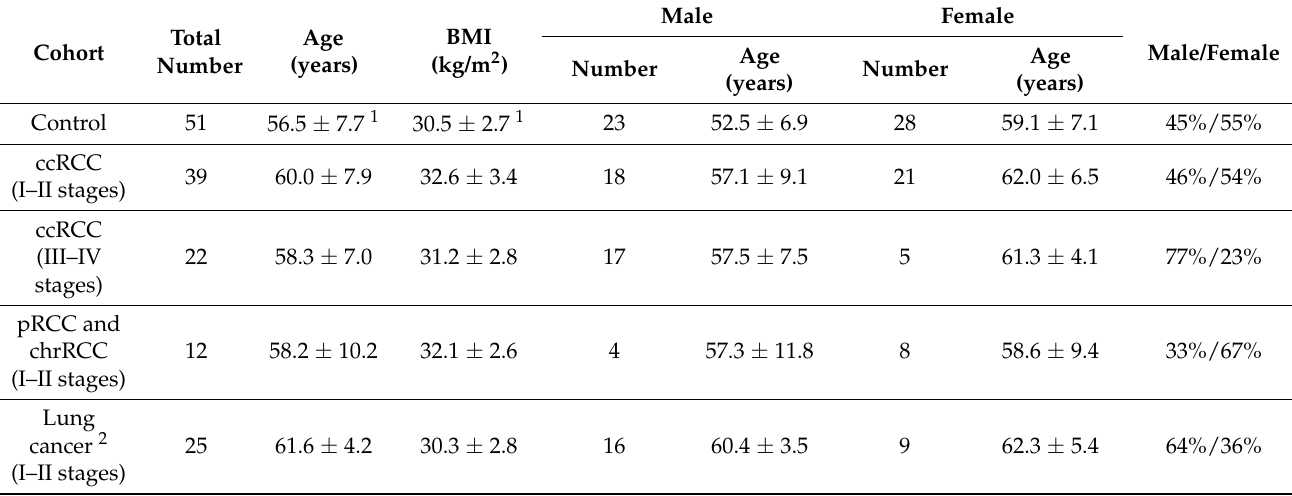
Table 1. Summary of the